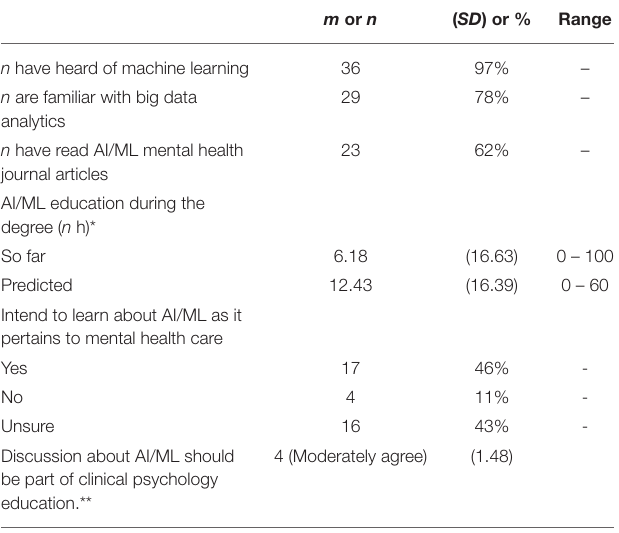
TABLE 3 | AI/ML education experience and interest.